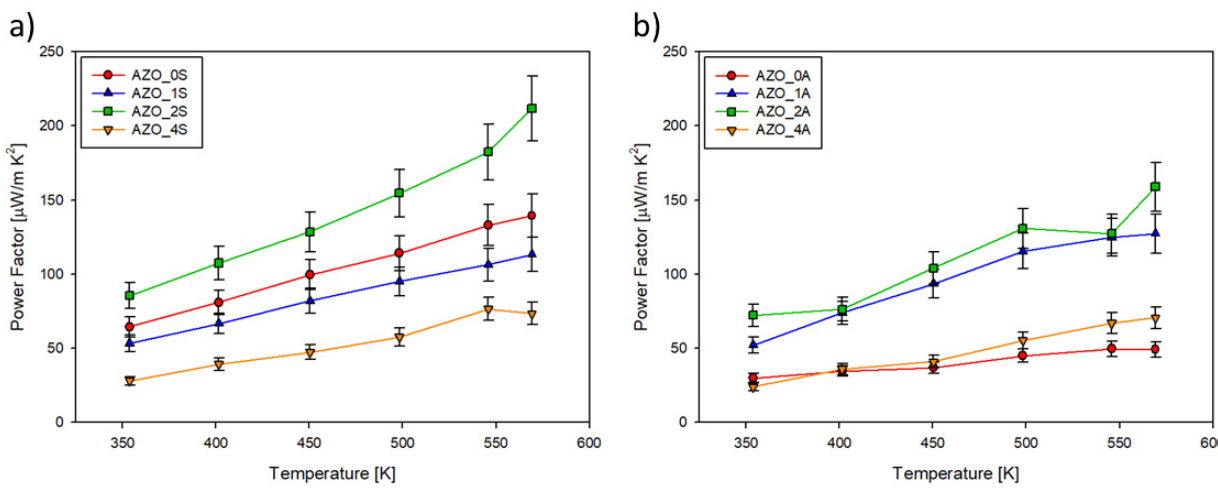
Figure 9. Power factor PF = σ S 2 plotted vs. temperature for thin films deposited on ( a ) silica (series AZO_xS) and ( b ) on Al 2 O 3 (series AZO_xA).